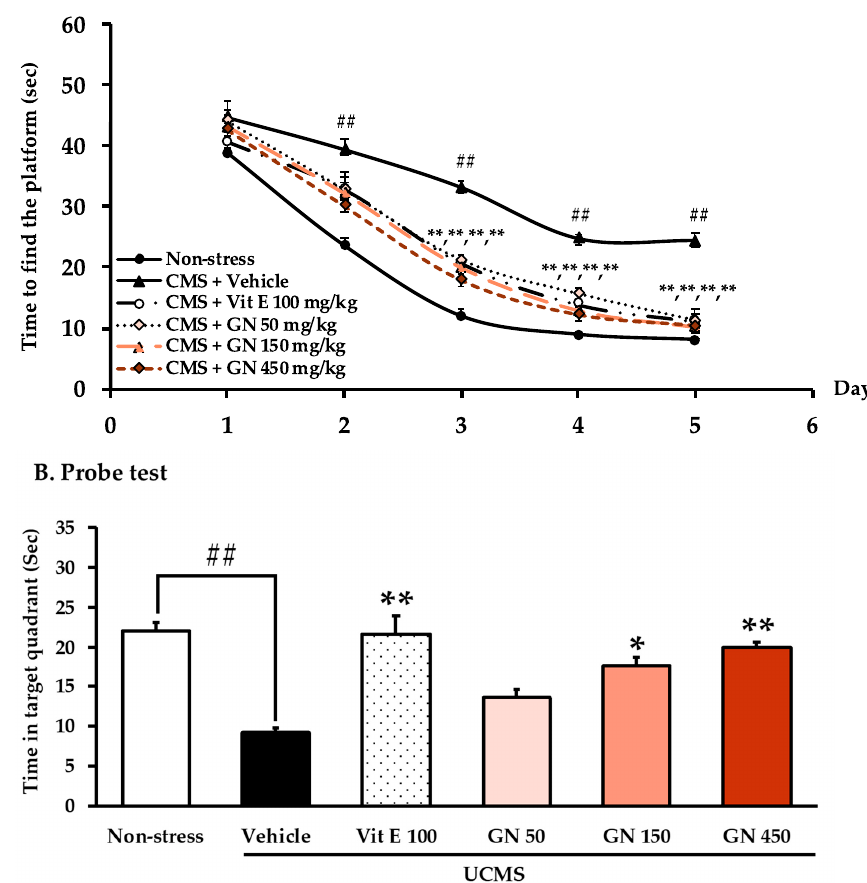
Figure 4. Latency time of training the mouse to find the target platform ( n = 10–11). Each data point represents the mean ± SEM of latency, 4 trials/day for 5 days ( A ). The effect of the GN bark resin extract on the UCMS-induced cognitive deficit in the MWMT ( B ). Each column represents the mean ± SEM ( n = 10–11). ## p < 0.001 vs. the vehicle-treated non-stress group. * p < 0.05, ** p < 0.001 vs. the vehicle-treated UCMS group (post-hoc Tukey test). To avoid the possibility of false positives from the hyper movement of animals that affects the behavioral model test, mice were observed for locomotor activity by counting the total arms of entry during 5 min of the mouse movement. The results showed that there was no significant difference in locomotor activity between experimental groups.